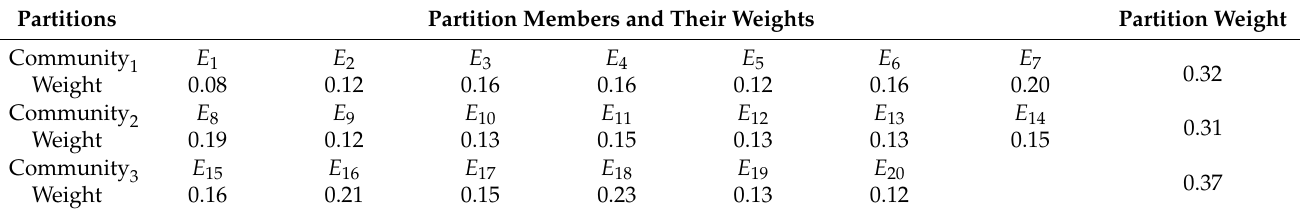
Table 1. The weights of partitions and